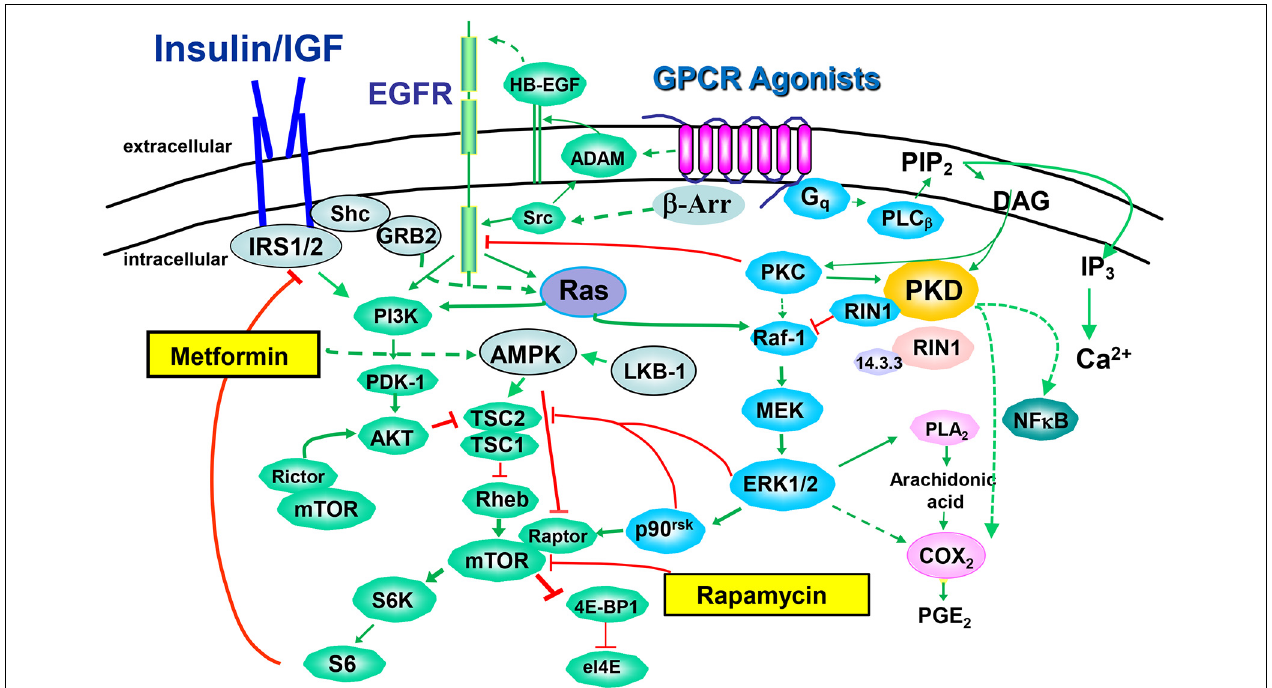
FIGURE 2 | Crosstalk between insulin/IGF-1 receptors and GPCR signaling systems. The binding of an agonistic ligand to its cognate GPCR triggers the activation of multiple signal transduction pathways via heterotrimeric G proteins, including Gq/11. GPCRS also signal via arrestin ( β -Arr) in a G protein-independent manner. A rapid increase in the activity of phospholipases C leads to the synthesis of lipid-derived second messengers, Ca 2 + fluxes and subsequent activation of protein phosphorylation cascades, including PKC/PKD, Raf/MEK/ERK and Akt/mTOR/p70S6K. The EGFR has emerged as a transducer in the signaling by GPCRs, a process termed EGFR